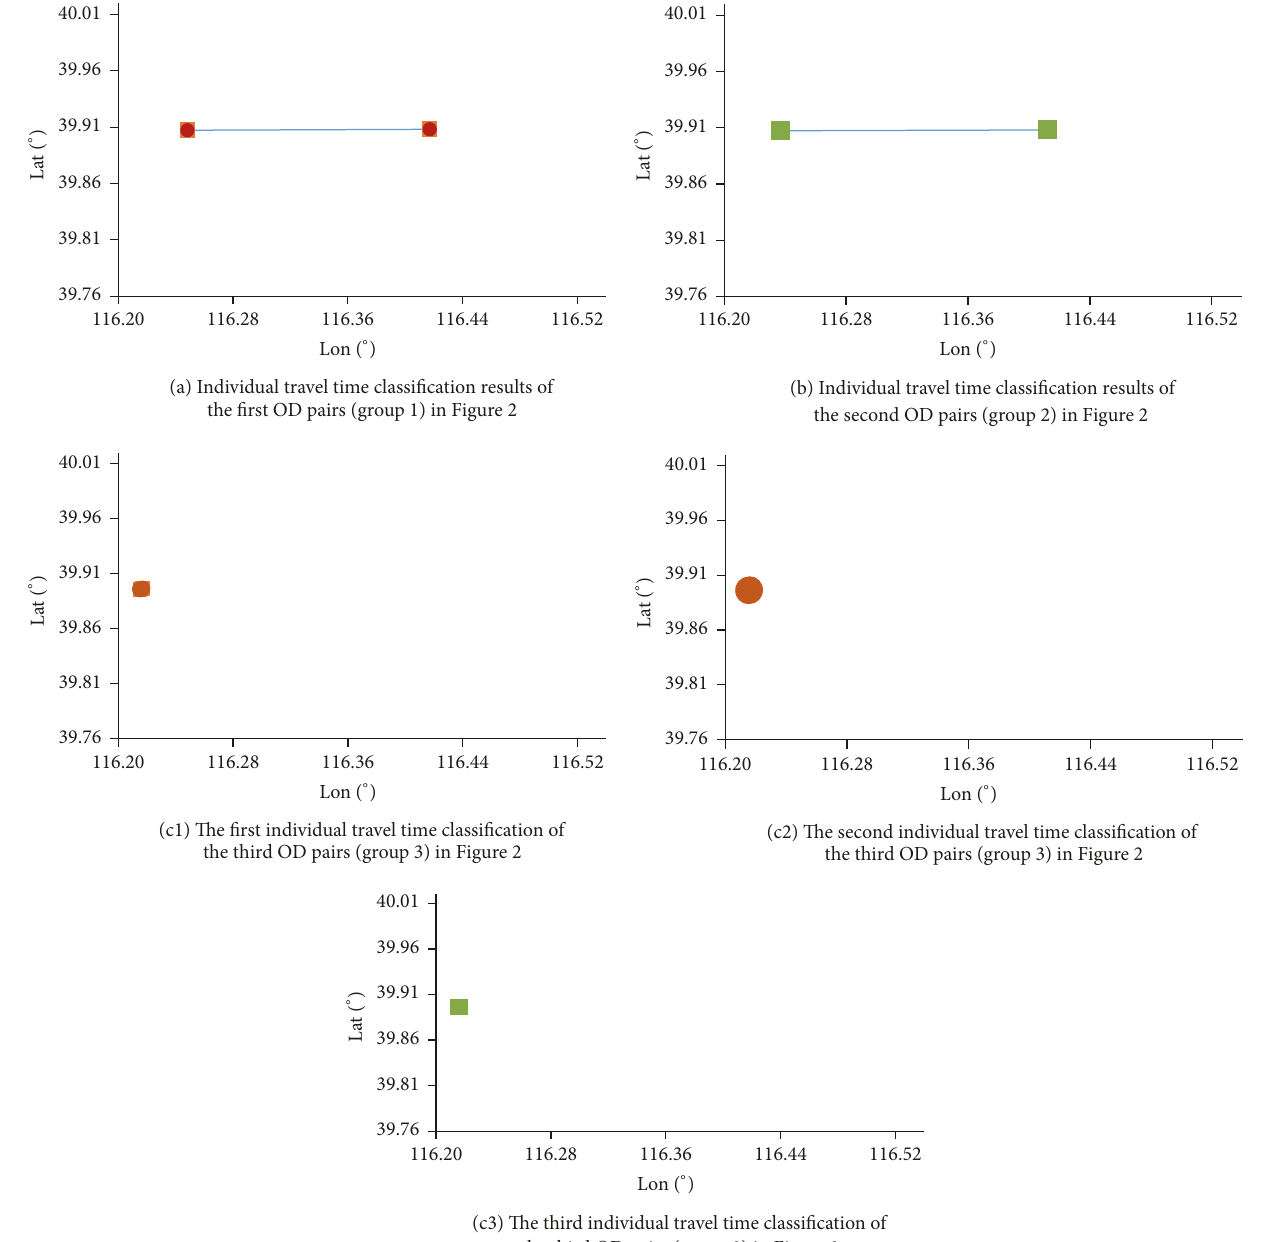
Figure 3: Examples of passenger travel time classification results of P1 in Figure